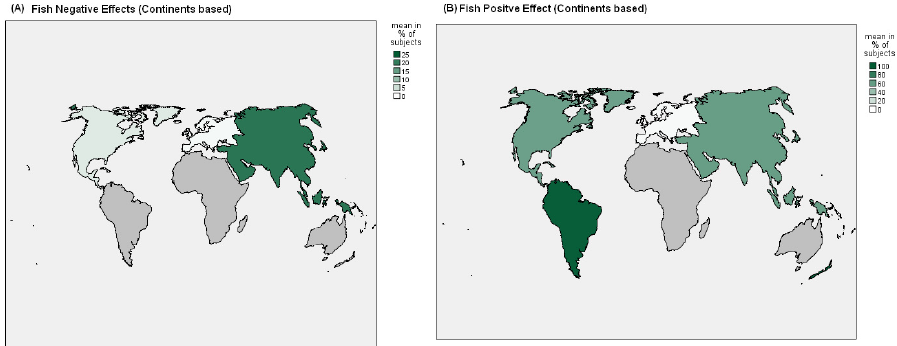
Figure 3. Continents positive effects (on total population) of “meat (A) and fish (B) ” dietary patterns on BMD or risk of fractures.